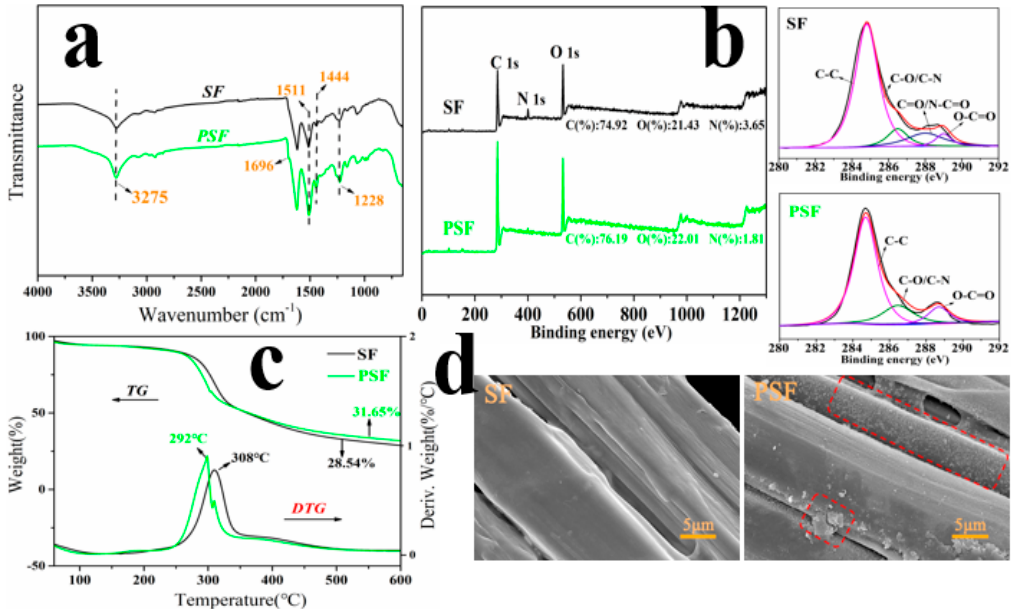
Figure 2. FTIR spectrum of untreated silk fiber (SF) and dopamine coated-SF (PSF; a ), X-ray photoelectron spectroscopy (XPS) wide scan and C 1s core-level spectra of untreated SF and PSF ( b ), thermogravimetric (TG) and derivative thermogravimetric (DTG) curves of SF before and after dopamine coating ( c ), and SEM images of SF and PSF ( d ).